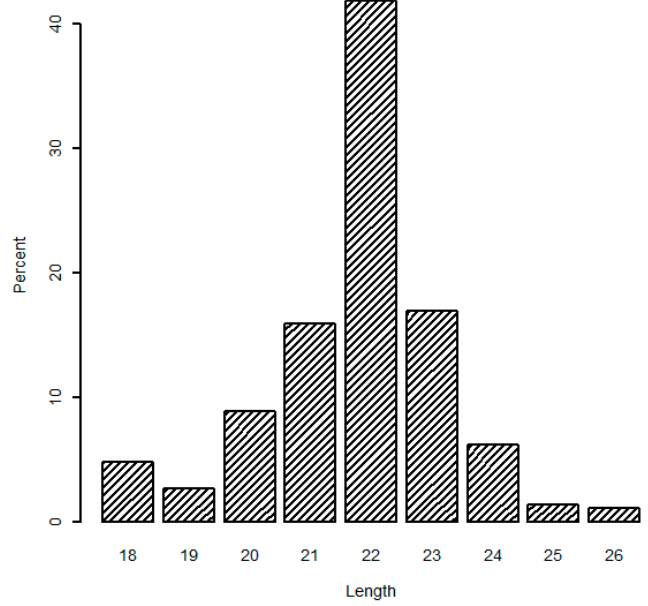
Figure 1. The length distribution of mappable sequences.